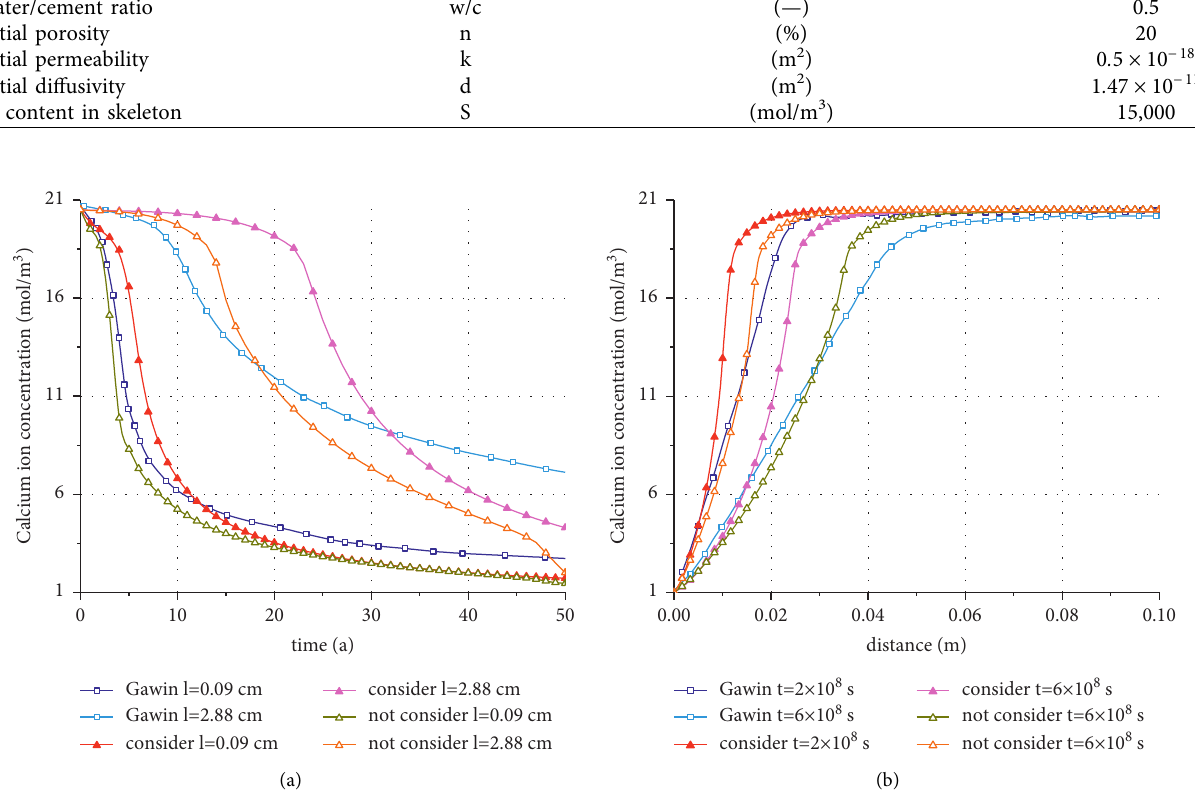
Figure 7: Time history of calcium ion concentration in pore solution and its space distributions at different time stations, obtained from simulations of considered different calcium compounds decomposition effect (solid dot) or not (empty dot) and compared to Gawin’s results (empty square). (a) Time history. (b) Space